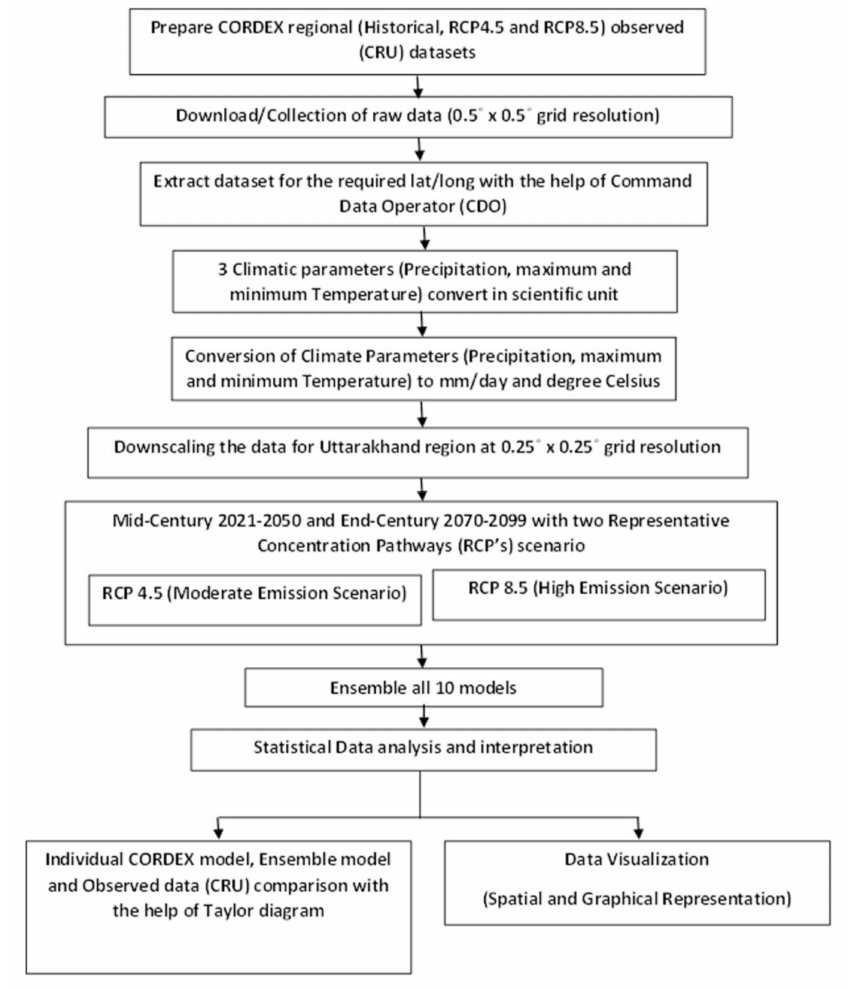
Figure 2. Flow chart of